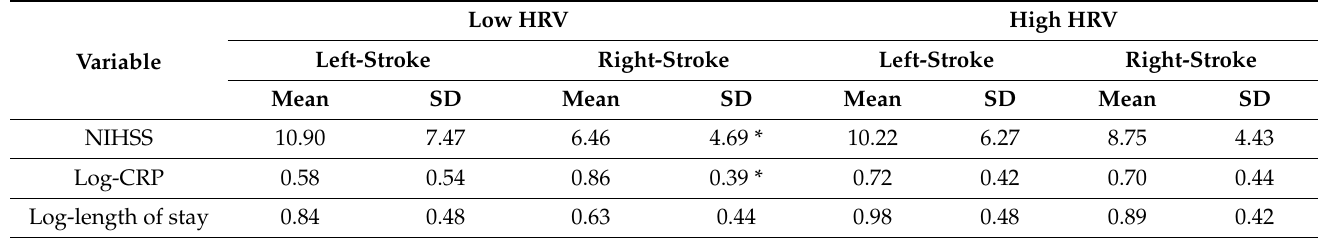
Table 2. Means (SD) for main study variables as function of stroke side and level of vagal activity